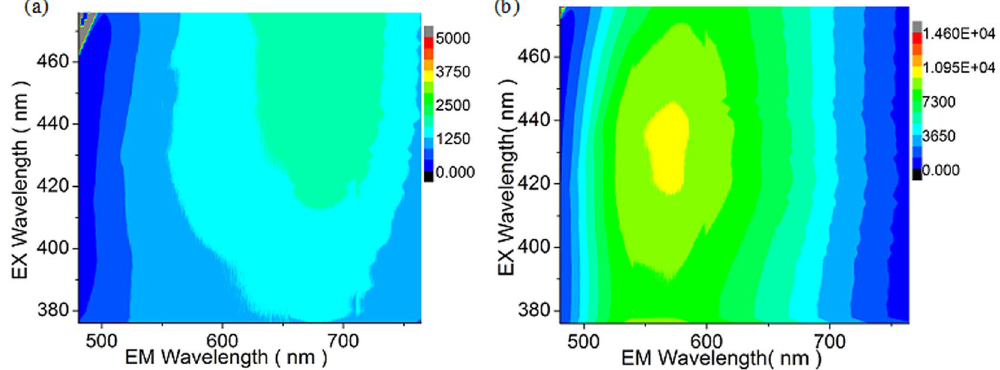
Figure 2. Photoluminescence excitation (PLE) contour graphs of ( a ) untreated and ( b ) 30 min ozone treated GO samples. X and Y axis represent emission and excitation wavelengths,